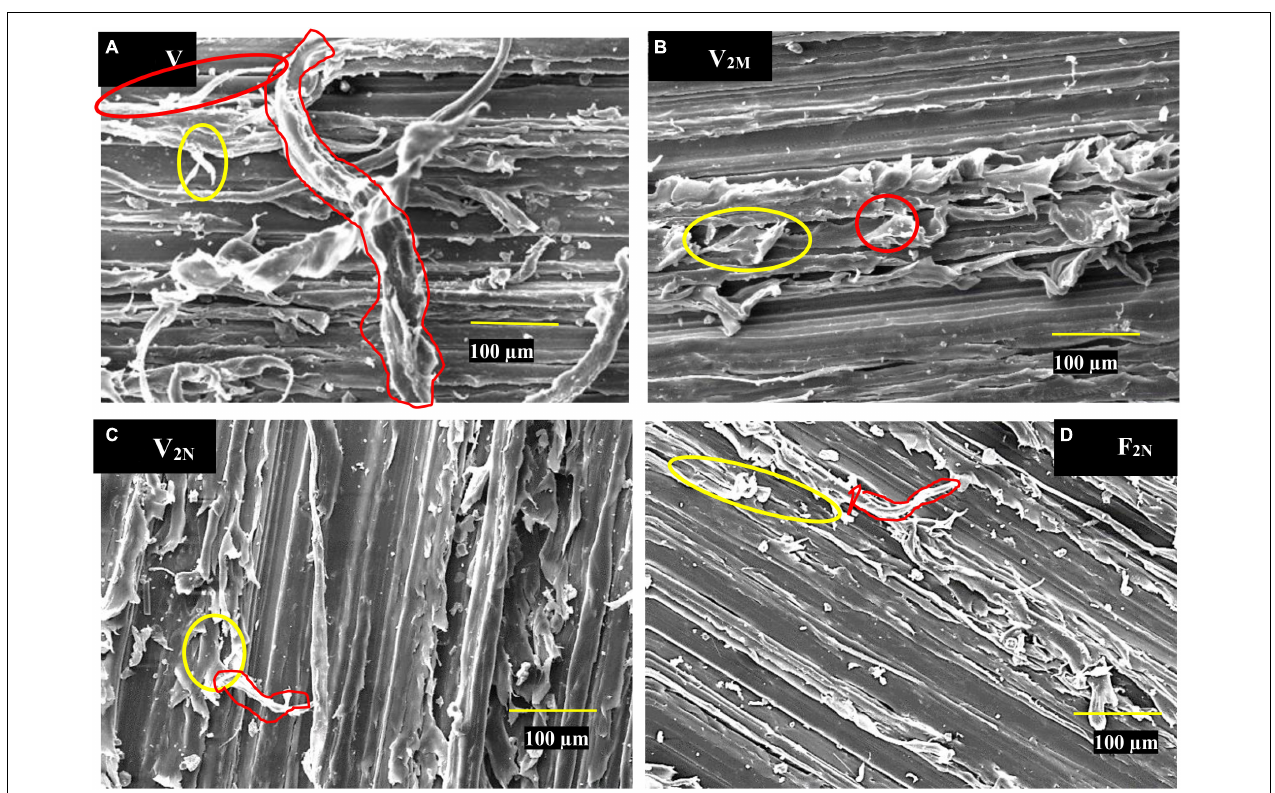
FIGURE 10 | Worn surfaces of composite pins abraded by SiC paper at 75 N, 25 mm/s for (A) V 0 , (B) V 2 M , (C) V 2 N , and (D) F 2 N (secondary micro-cutting indicated by yellow